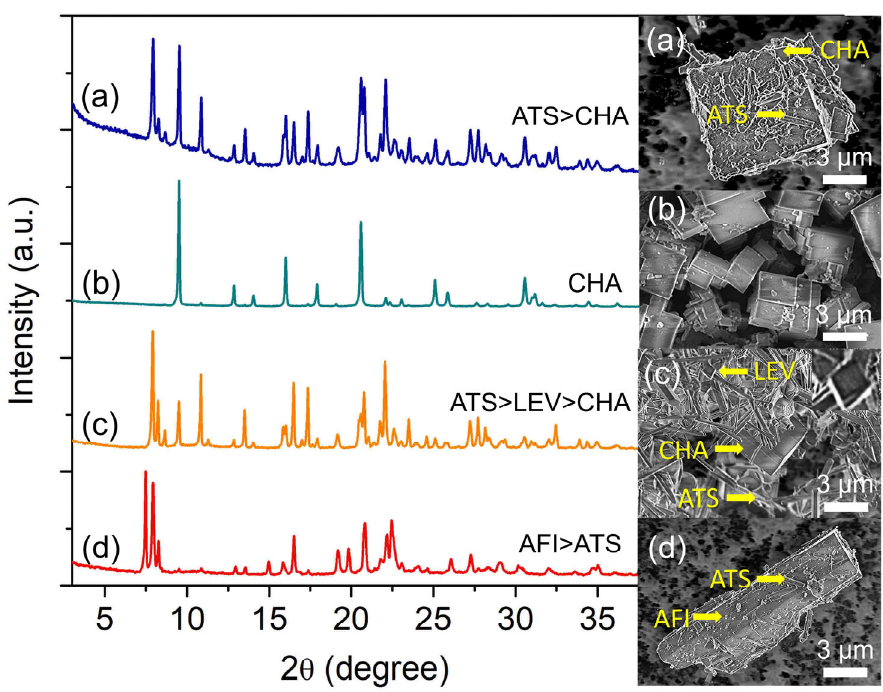
Figure 5. XRD patterns and FESEM micrographs of ( a ) S ‐ 14 ( z = 116), ( b ) S ‐ 3 ( z = 148), ( c ) S ‐ 15 ( z = 180), and ( d ) S ‐ 16 ( z = 240) samples. The samples were prepared using the hydrogel of 2.0 Al: 4.7 P: 0.9 Si: 6.7 [PrPy]OH: z H 2 O heated at 200 °C for 19 h.